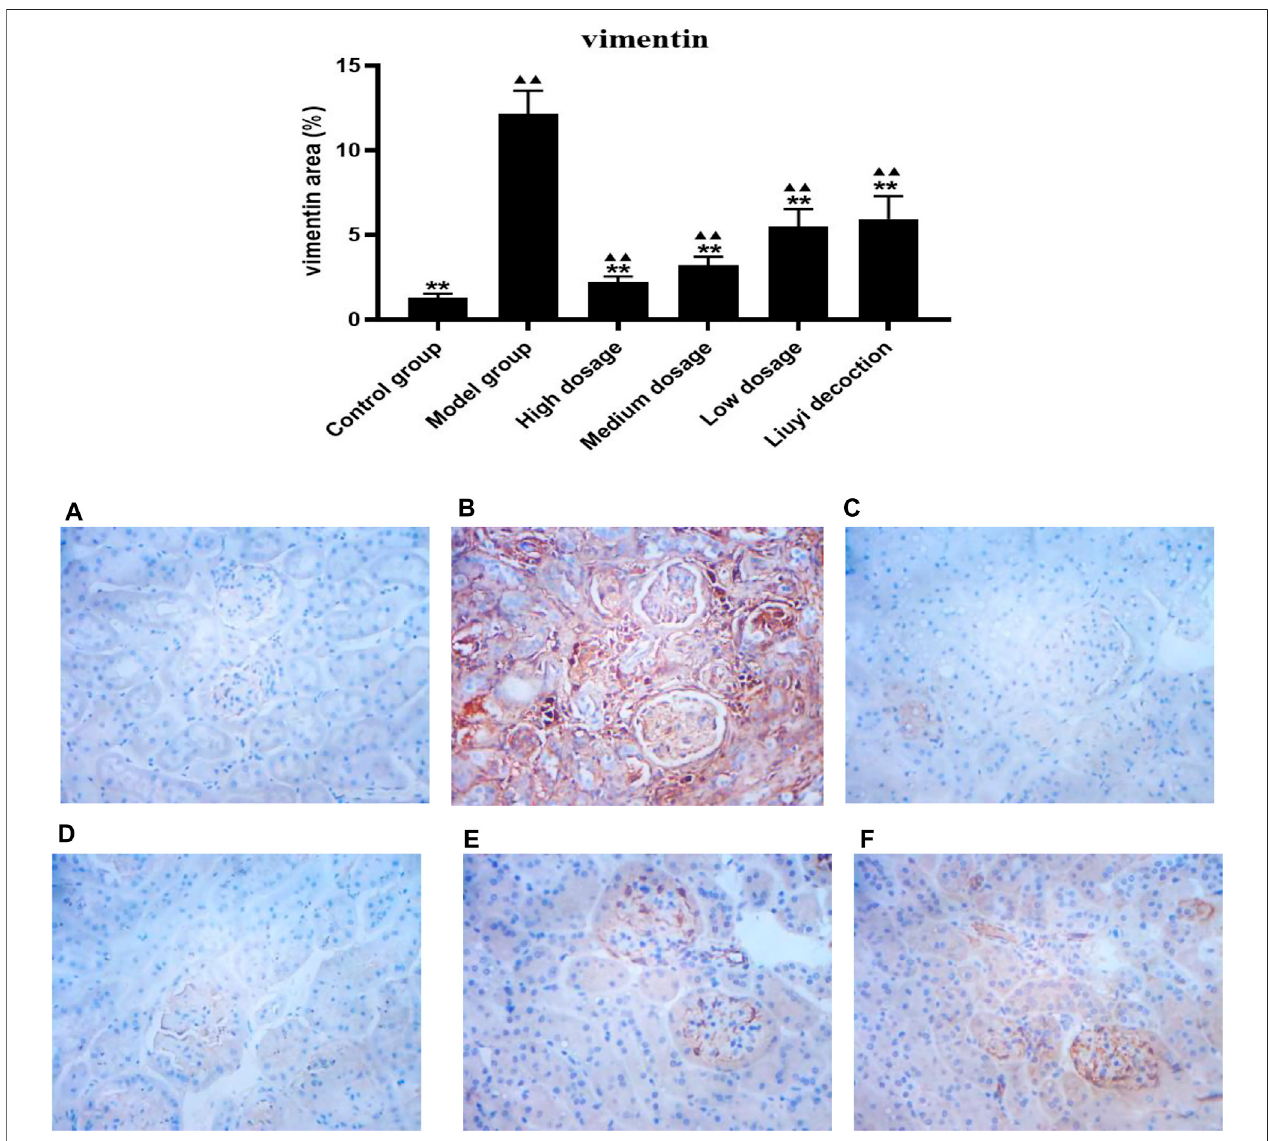
FIGURE 8 | Effect of HQD on the expressions of vimentin in kidney (×400). Control group (A) ; model group (B) ; high dosage (C) ; medium dosage (D) ; low dosage (E) ; Huangqi Liuyi decoction (F) . ps: vs. Model group, * P < 0.05, ** P < 0.01; vs control group, ▲ P < 0.05, ▲▲ P < 0.01 (x±SD, n =6).